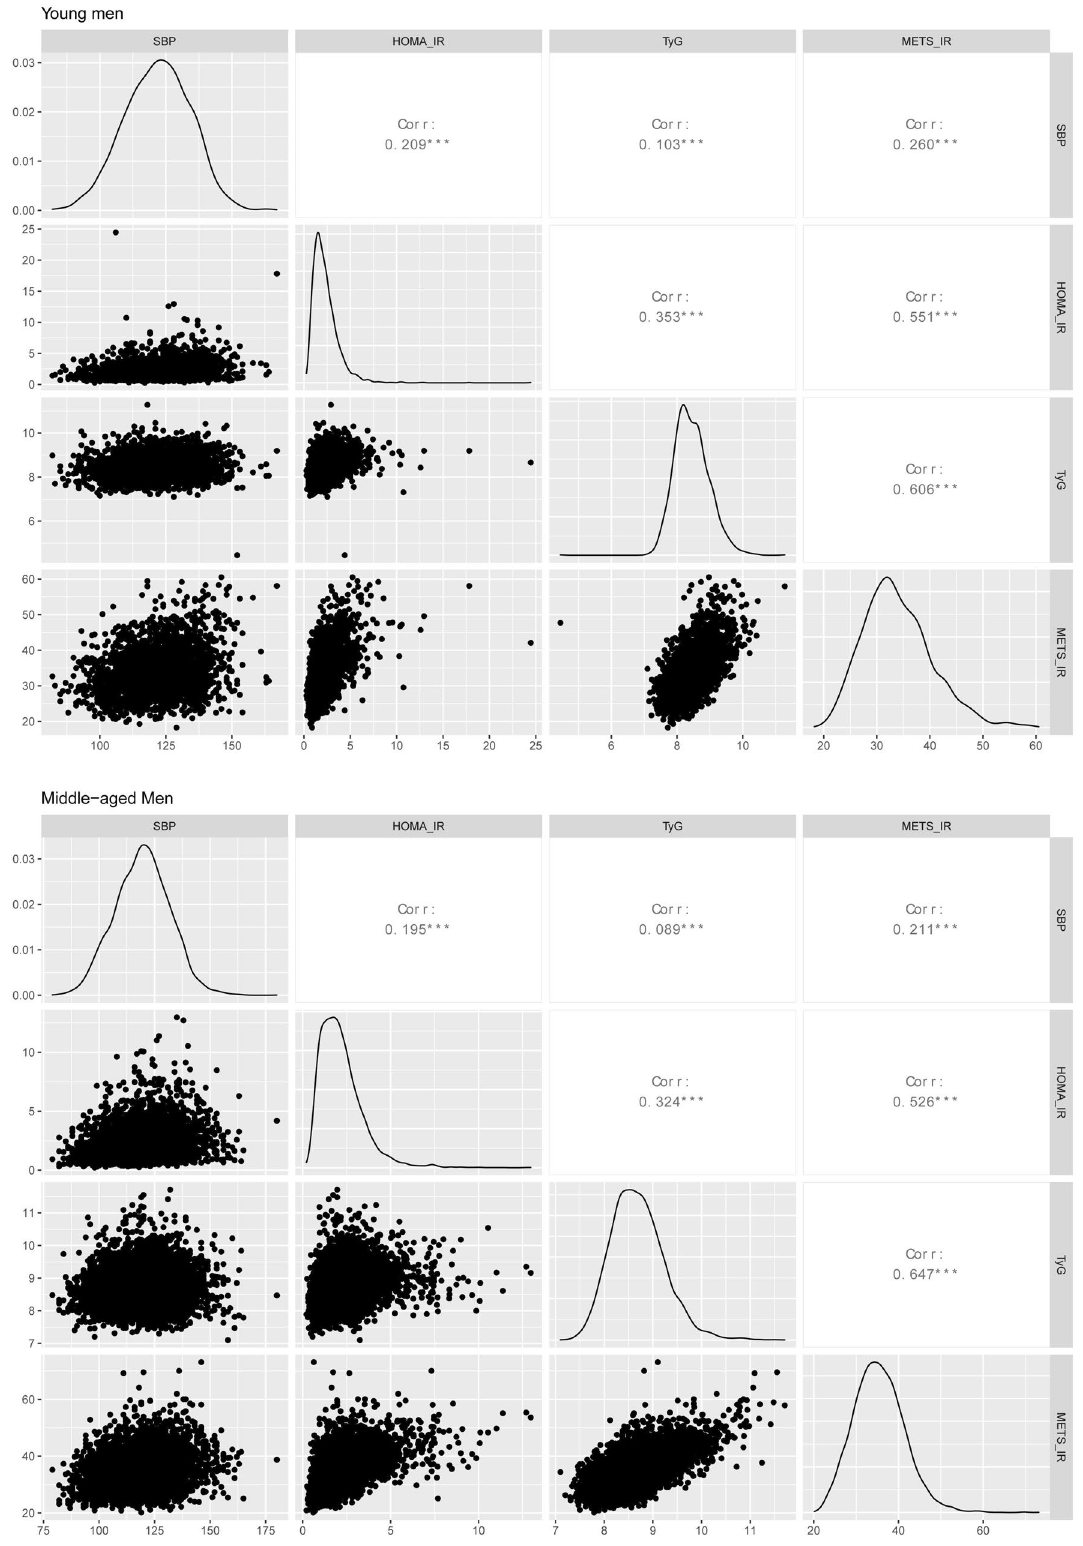
Figure 1. The correlation matrix between systolic blood pressure and insulin resistance indicators. SBP systolic blood pressure, IR insulin resistance, HOMA-IR homeostasis model assessment for IR index, TyG triglyceride glucose index, METS-IR metabolic score for